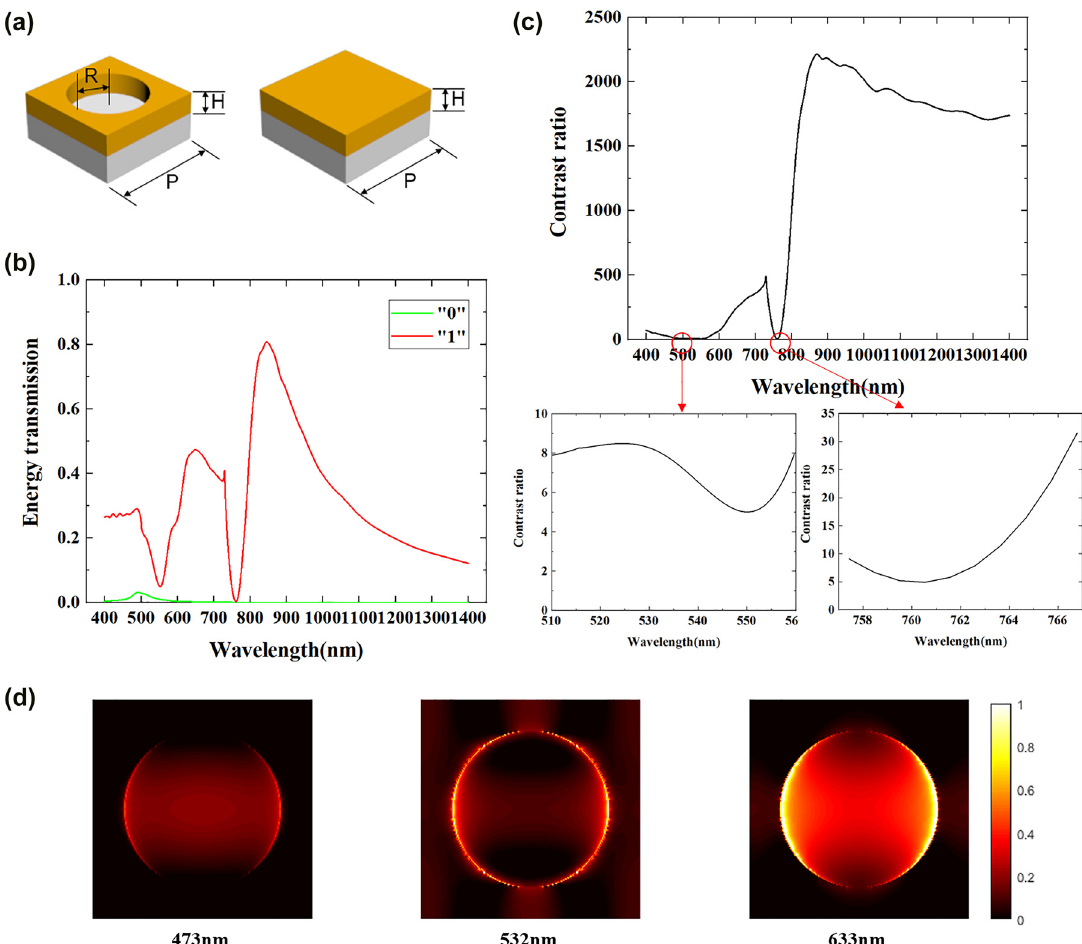
Figure 2: Simulated transmission spectrum of the designed photon sieves. (a) Schematic illustration of gold films on a glass substrate. Left: transparent unit (‘1’); Right: opaque unit (‘0’); the period, thickness and radius of the nanohole is set as: P = 500 nm, H = 100 nm, R = 180 nm. (b) Simulated transmission spectrum of unit cell. (c) Contrast transmission ratio between the two transparent and opaque unit. (d) The near-field distribution within one nanohole at 473, 532 and 633 nm wavelength,